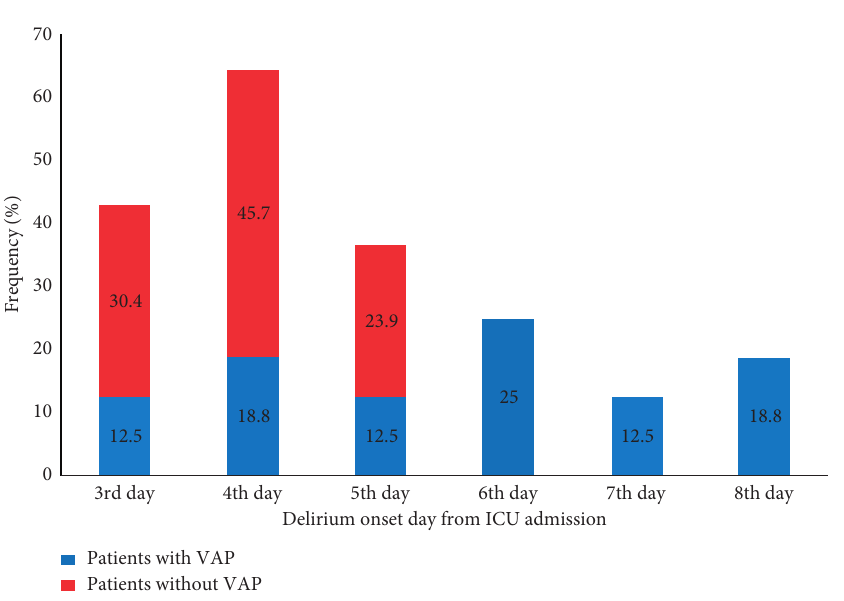
Figure 1: Comparison of early- versus late-onset delirium in patients with and without VAP ( P < 0 . 05 )